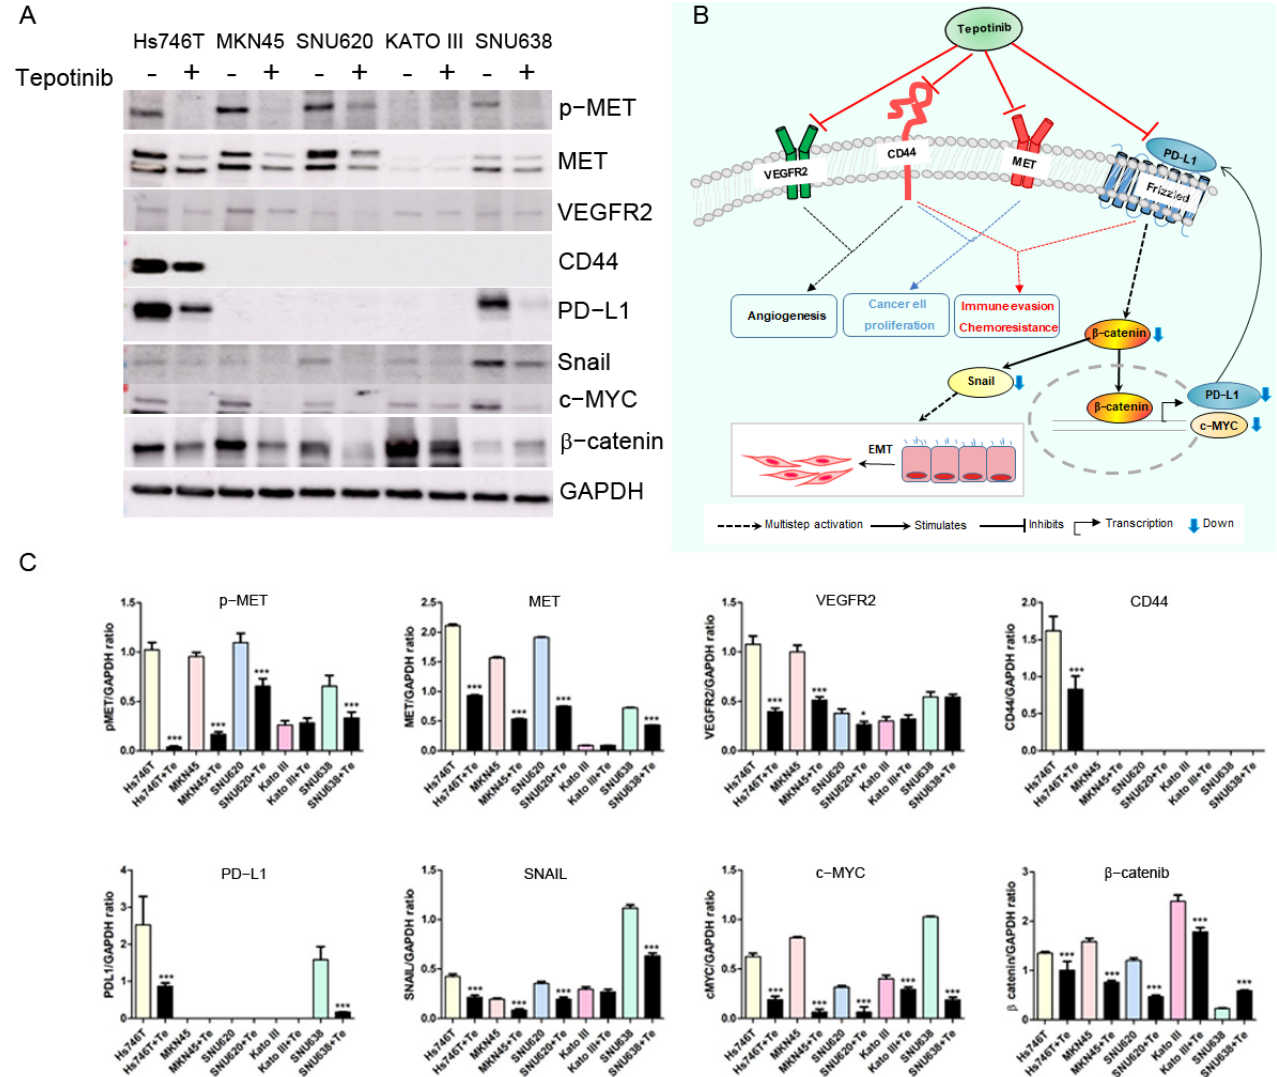
Figure 5. Effects of tepotinib on protein expression in GC cells. Protein expression of SNU620, MKN45, Hs746T, Kato III, and SNU638 cell lines. ( A ) Protein expression levels of MET, p-MET, VEGFR2, CD44, PDL1, Snail, c-MYC, and β -catenin were determined using immunoblot analysis. Hs746T, MKN45, Kato III, and SNU638 cell lines were treated with 1 µM tepotinib, and the SNU620 cell line was treated with 10 nM tepotinib for 48 h. ( B ) Graphic overview of tepotinib-treated interventions in GCs with MET amplification or METex14SM and high expression of both PD-L1 and CD44. ( C ) Using the image J for densitometry analysis. * p < 0.05 and *** p < 0.001 compared with the control group.